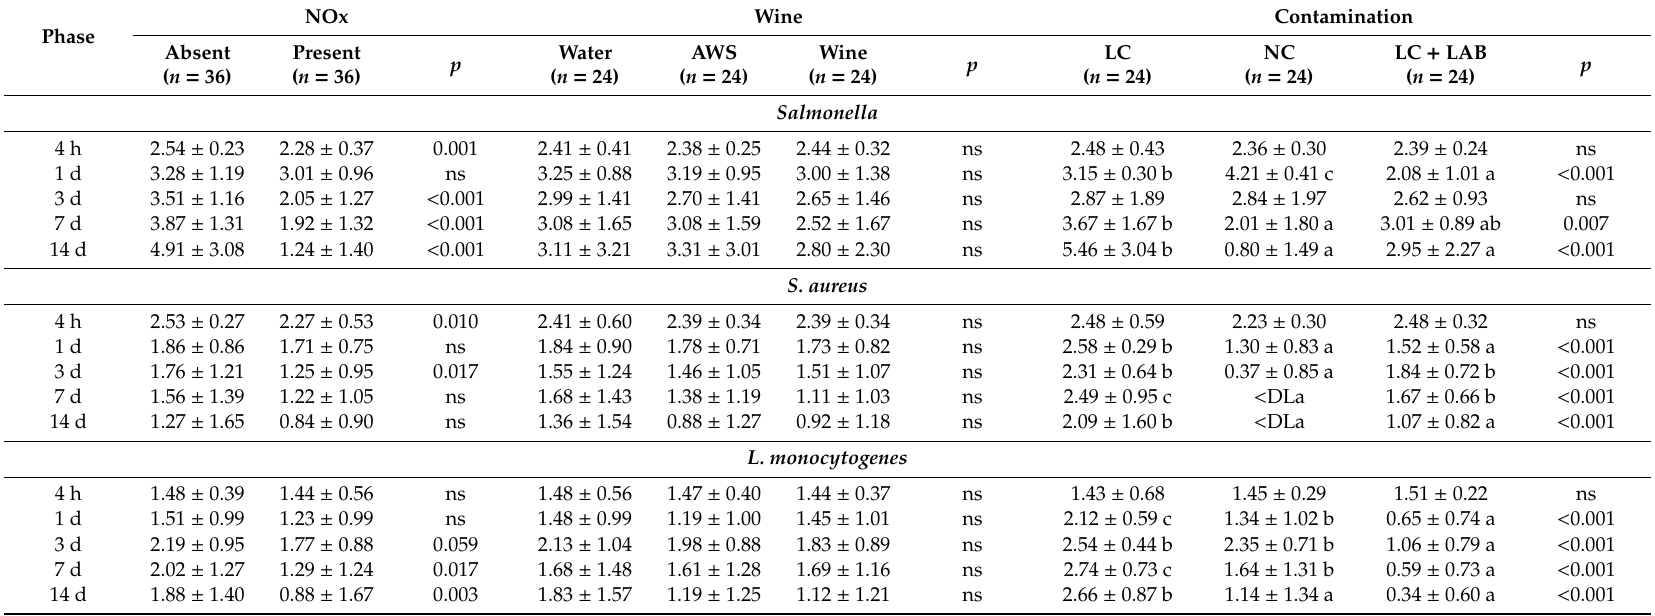
Table 2. Comparisons of the counts of the three pathogens in chouriço batter made with or without curing salts (NOx), with wine or artificial wine solution (AWS) or water, using low contaminated meat (LC), normal contaminated meat (NC), and low contaminated meat inoculated with L. sakei (LC + LAB). The results are expressed as the mean ± standard deviation of log cfu /